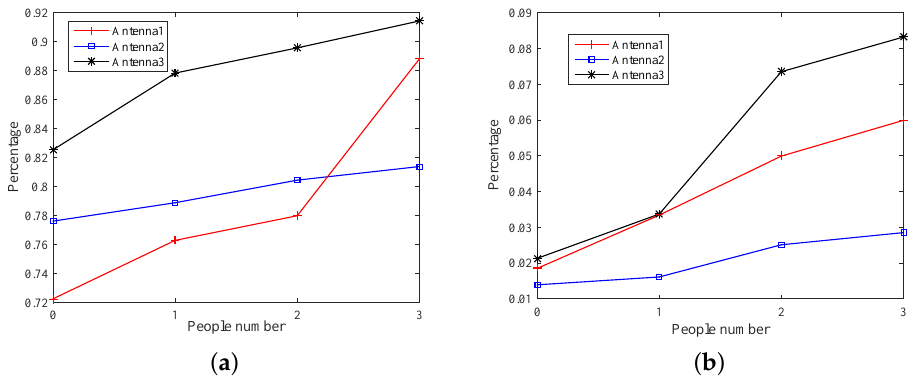
Figure 8. The relationship between the number of people and the percentage at the different antennas. ( a ) amplitude; ( b )